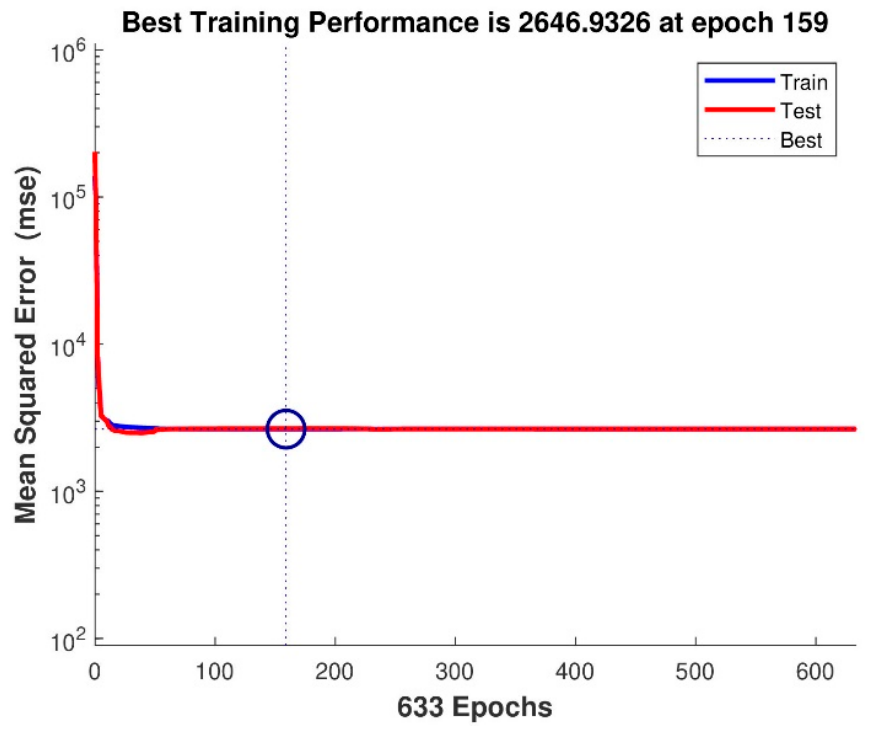
Figure 11. Performance analysis of the neural network (solar irradiance forecasting case).